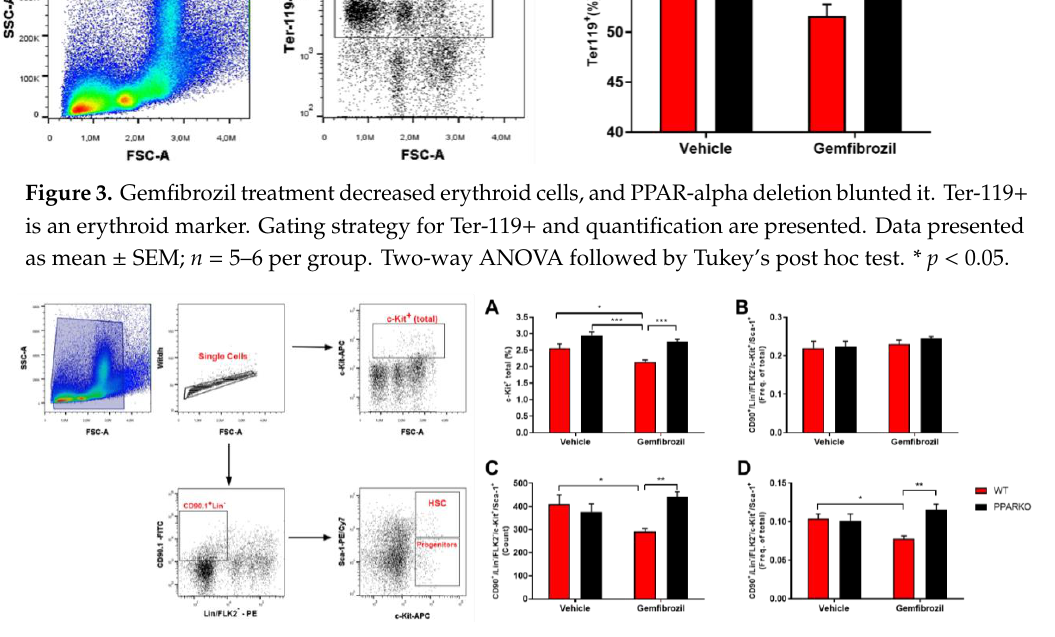
Figure 4. Gemfibrozil treatment reduced hematopoietic stem cells in the bone marrow, and PPAR-alpha deletion reversed it. Gating strategy for HSCs and progenitor cells is presented. Gemfibrozil reduced c-Kit + ; ( A ) Frequency of progenitors showed no di ff erence; ( B ) Gemfibrozil decreased HSC count; ( C ) and total frequency; ( D ) while PPAR-alpha deletion blunted these e ff ects of gemfibrozil. Data presented as mean ± SEM; n = 5–6 per group. Two-way ANOVA followed by Tukey’s post hoc test. * p < 0.05; ** p < 0.01; *** p < 0.001.